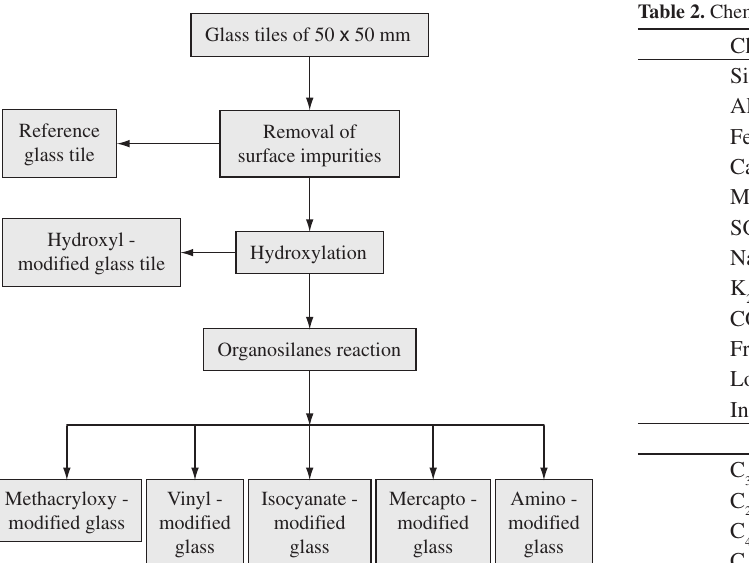
Figure 1. Flowchart of glass tile surface modification procedure.